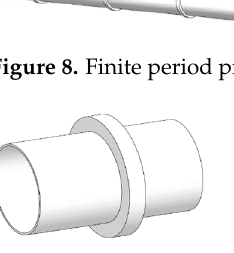
Figure 9. Single periodic structure.